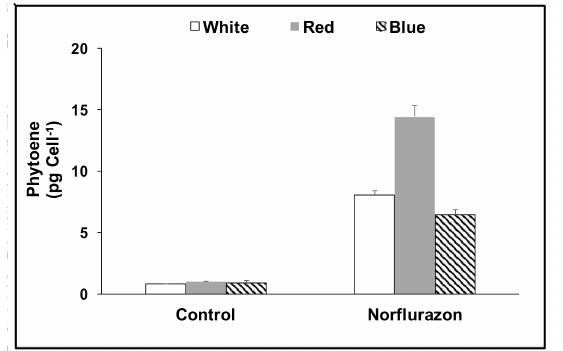
Figure 5. Cellular content of phytoene in cultures treated with no inhibitors (control) or with 5 µ M norflurazon. Cultures were maintained under red, blue and white LED light at 200 µ mol m − 2 s − 1 for 48